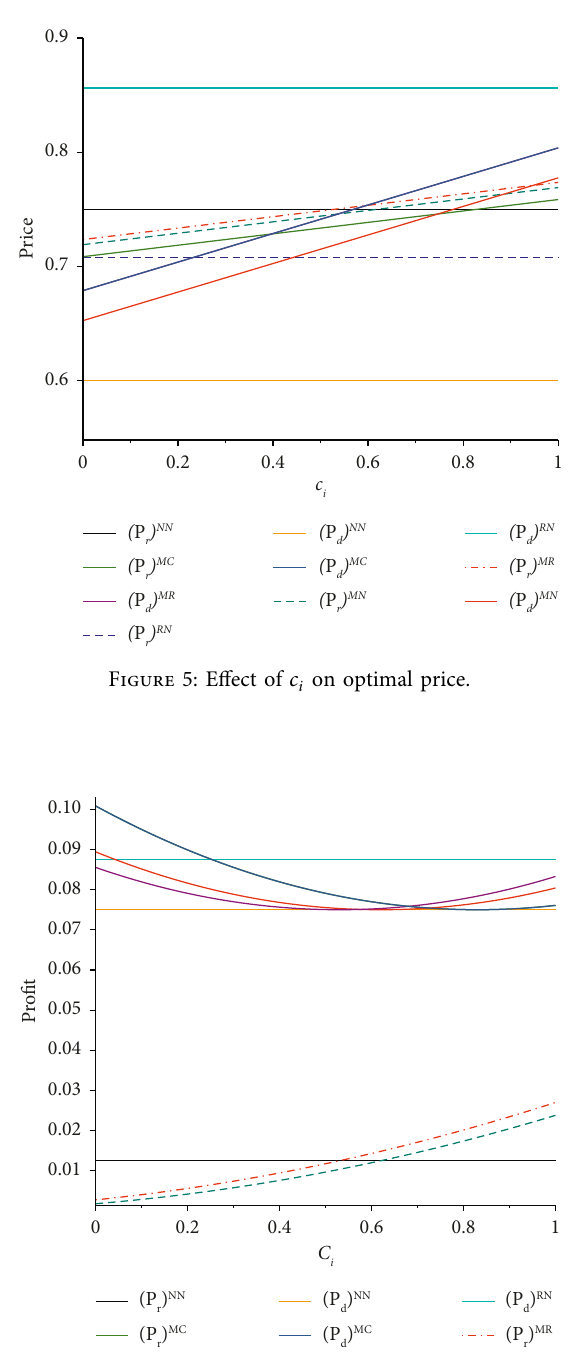
i on optimal profit.